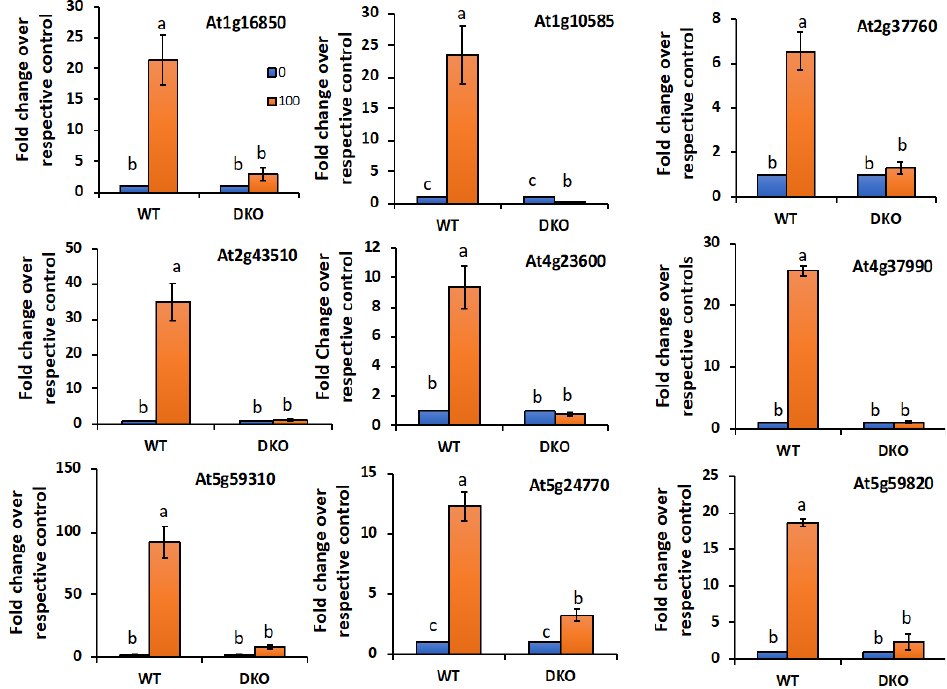
Figure 9. VOZs positively regulate the expression of salt-responsive genes. Expression of salt-responsive genes in 10-day-old seedlings of WT and DKO lines on 1/2 MS medium supplemented with 0 or 100 mM NaCl was determined by RT-qPCR. The expression level of salt-responsive genes was normalized with ACTIN2 . Fold change in expression level relative to their respective controls (0 mM) is presented. 0 mM values were considered as 1. Three biological replicates were used. Student’s t -test was performed and significant differences ( p ≤ 0.05) among samples are labeled with different letters. The error bars represent SD.